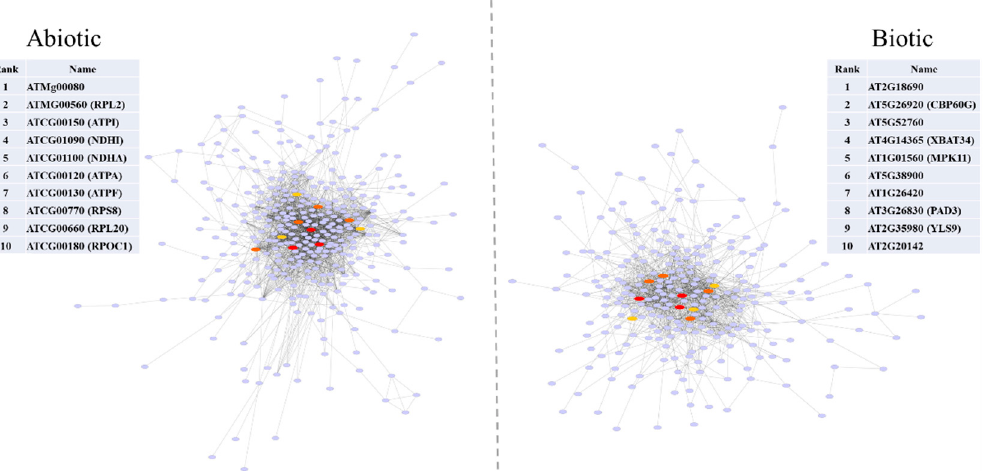
Figure 3. A protein-protein interaction network highlights hub genes involved in biotic and abiotic stresses in Arabidopsis . The most important hubs are ranked based on their importance in the network. The red, orange, and yellow nodes indicate the hub genes in each module.